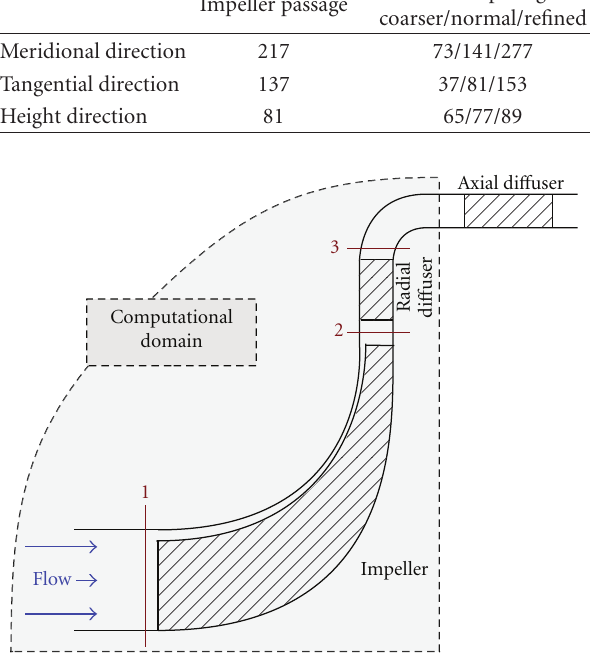
Figure 1: Numbering of planes used for performance computation.